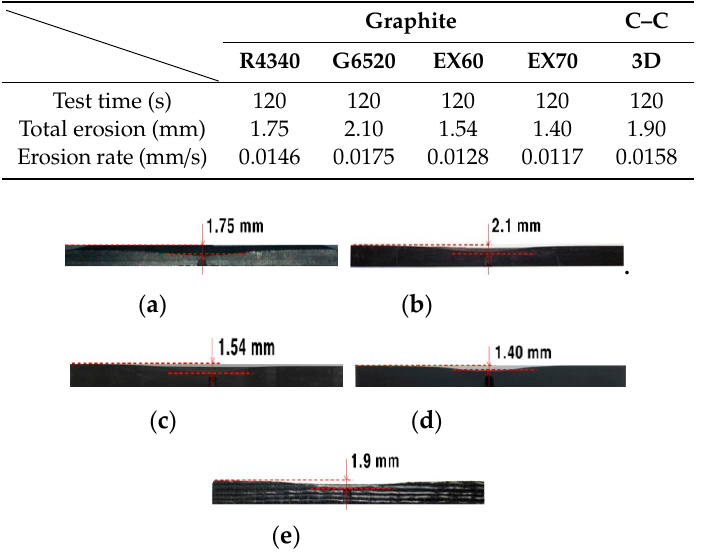
Figure 9. Erosion cross section view of ( a ) R4340 ( b ) G6520 ( c ) EX60 ( d ) EX70 ( e ) the 3D C–C composite. Table 4. Calculated thermochemical erosion rate of graphite and the C–C composite. Graphite Graphite C–C